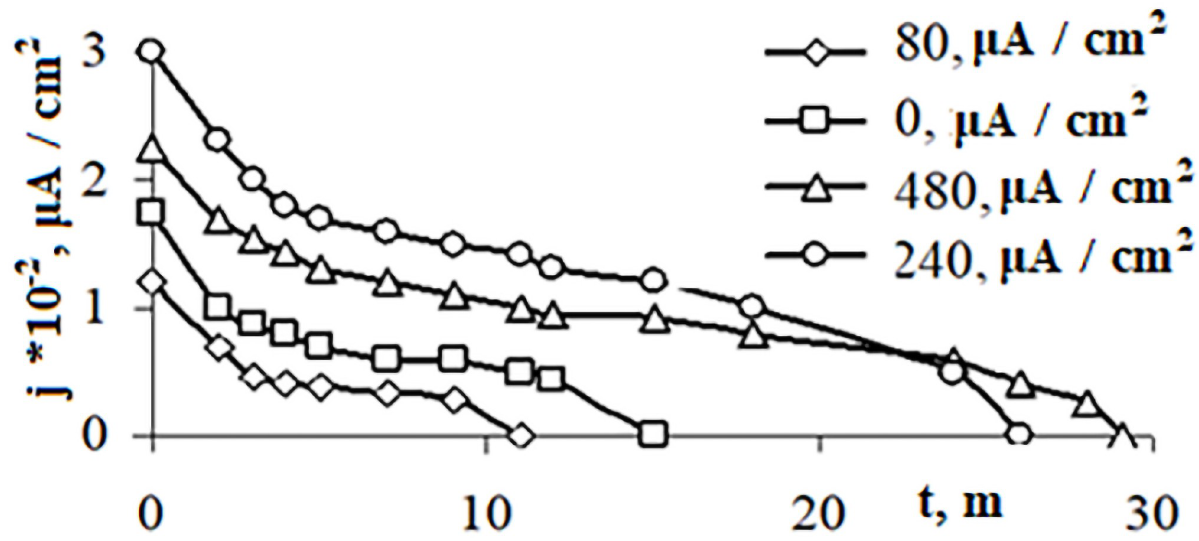
Fig 8. Potentiostatic curves obtained when copper was isolated from the eluate of the spent phytomass of Lemna minor duckweed at E = 0.32 V. The duckweed was previously placed into a copper sulfate solution with Cu 2+ ( Ci = 1 mg/L) under the influence of MF = 2 kA/m, at various current densities j , μ A/cm 2 .